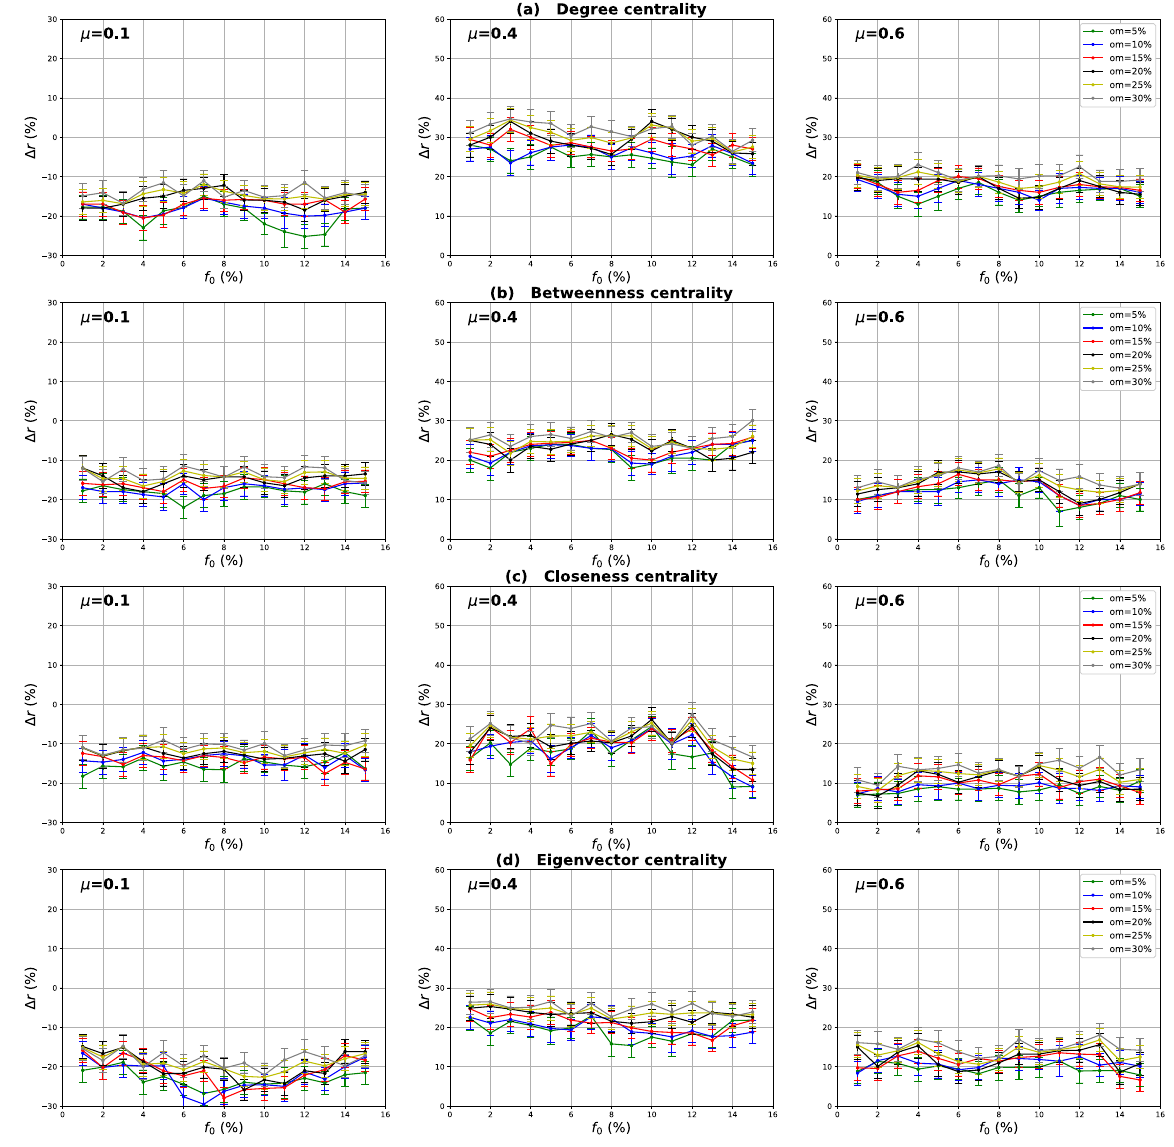
Figure 11. Influence of the community membership degree. The relative difference of the outbreak size Δ r between the standard measure and the Global measure versus the percentage of initial spreaders f 0 . The number of overlapping nodes value on is equal to 10% of the total number of the